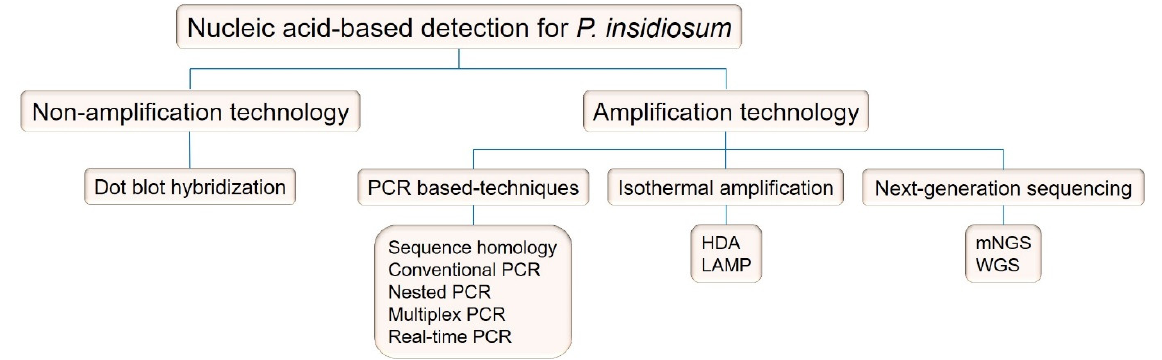
Figure 1. PRISMA ‐ based flow chart demonstrating the article ‐ procurement process.